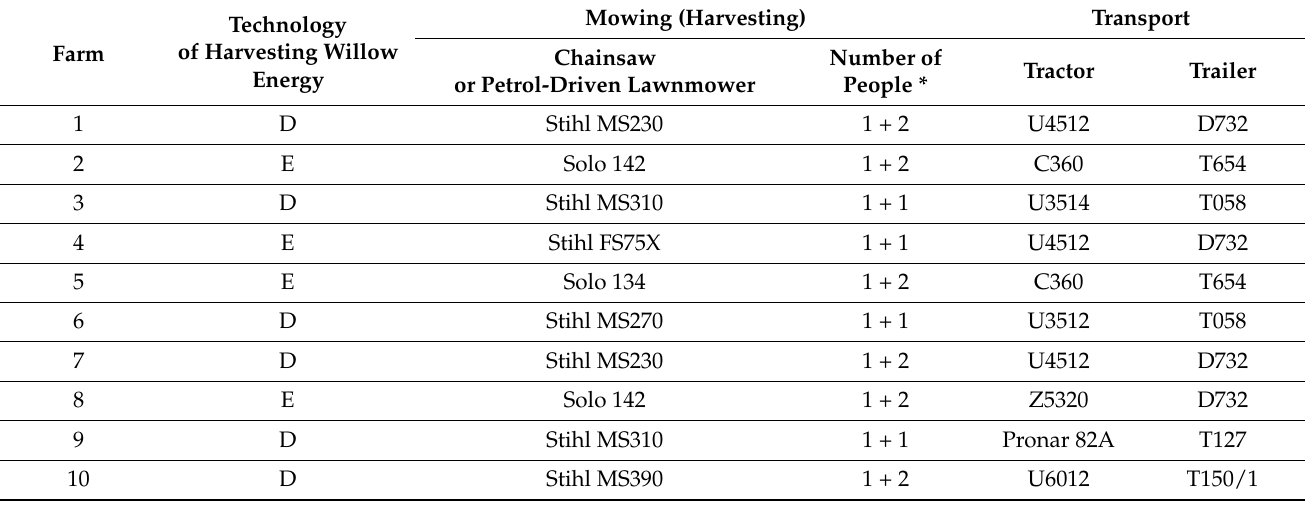
Table 4. Energy willow harvesting technology and machinery